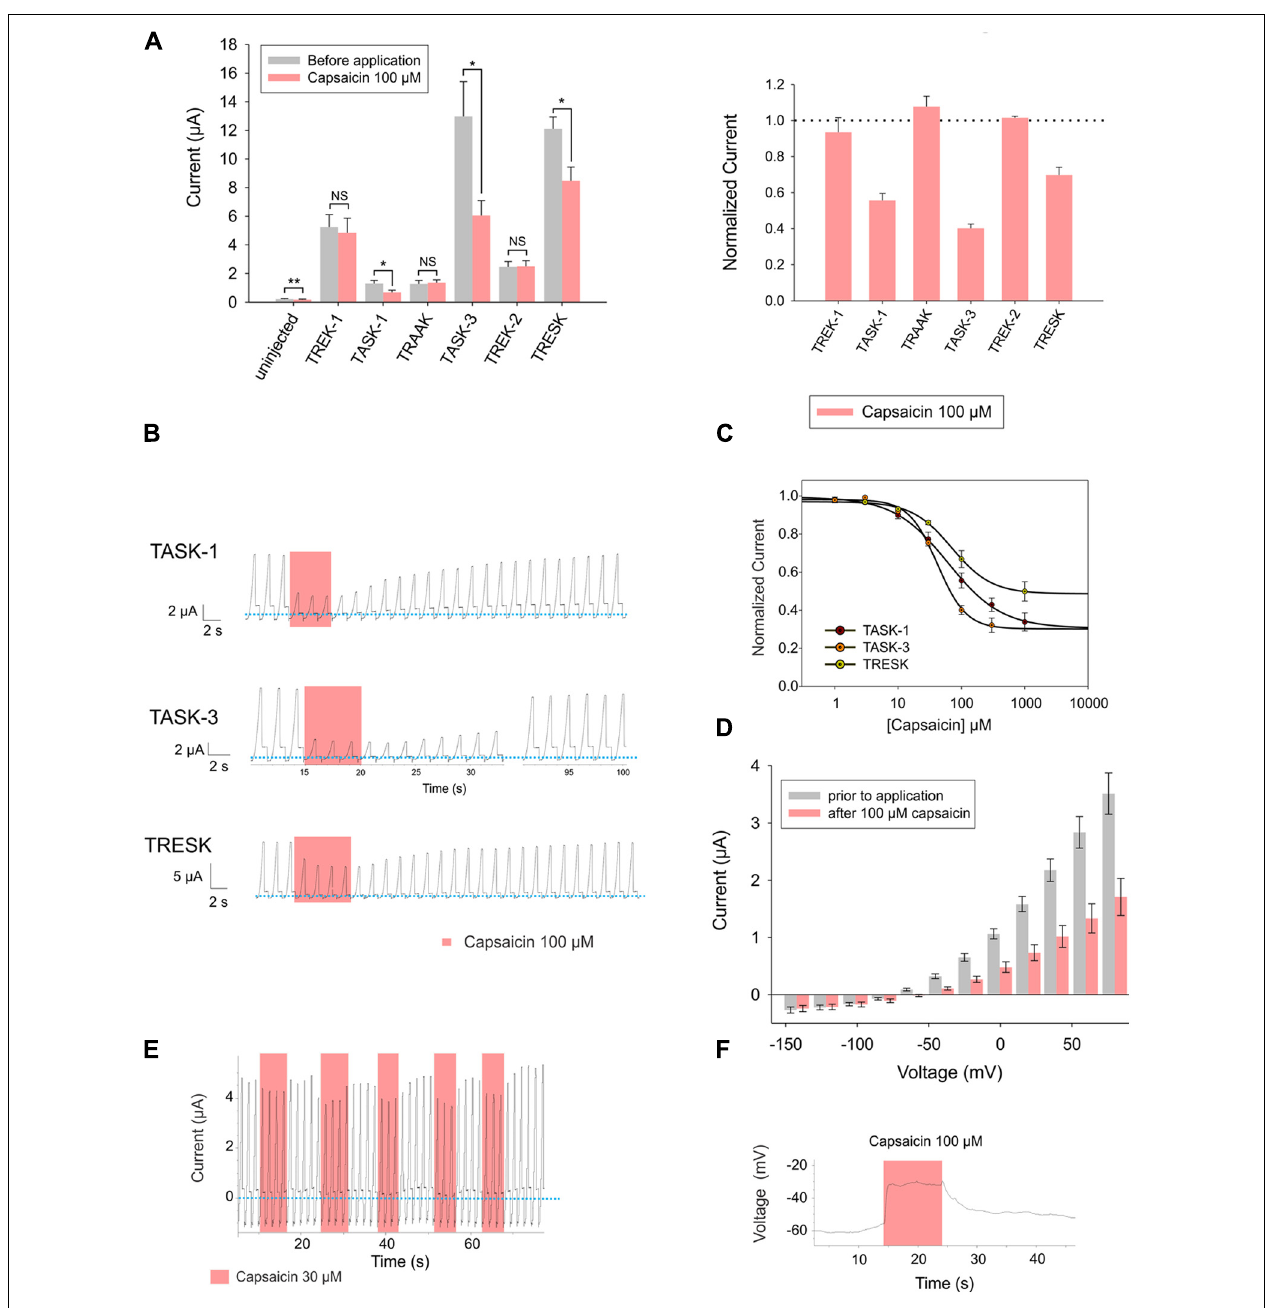
FIGURE 3 | (A) Left (from left to right) absolute currents presented by: uninjected Xenopus oocytes, oocytes injected with cRNA coding for hTREK-1, hTASK-1, hTRAAK, hTASK-3, hTREK-2 and hTRESK, before and after the application of 100 μ M capsaicin. Right : normalized currents showing the effect of 100 μ M capsaicin on Xenopus oocytes injected with cRNA coding for hTREK-1, hTASK-1, hTRAAK, hTASK-3, hTREK-2 and hTRESK. For each group, the current was normalized to the current registered prior to the application of 100 μ M capsaicin (dotted line). All data are expressed as the mean + / − SEM. N of 3–6 oocytes. * P < 0.05, ** P < 0.01. (B) Representative voltage clamp recordings of Xenopus laevis oocytes expressing TASK-1 (top), TASK-3 (middle) and TRESK (bottom), before, during and after the application of 100 μ M capsaicin, showing in every case a fully reversible inhibition. Dotted line represents zero current.